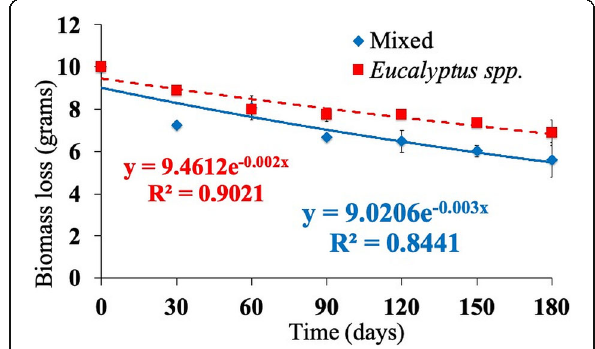
Fig. 2 Biomass loss over time for mixed species (diamonds with blue line) and Eucalyptus spp. (red squares with dotted line)